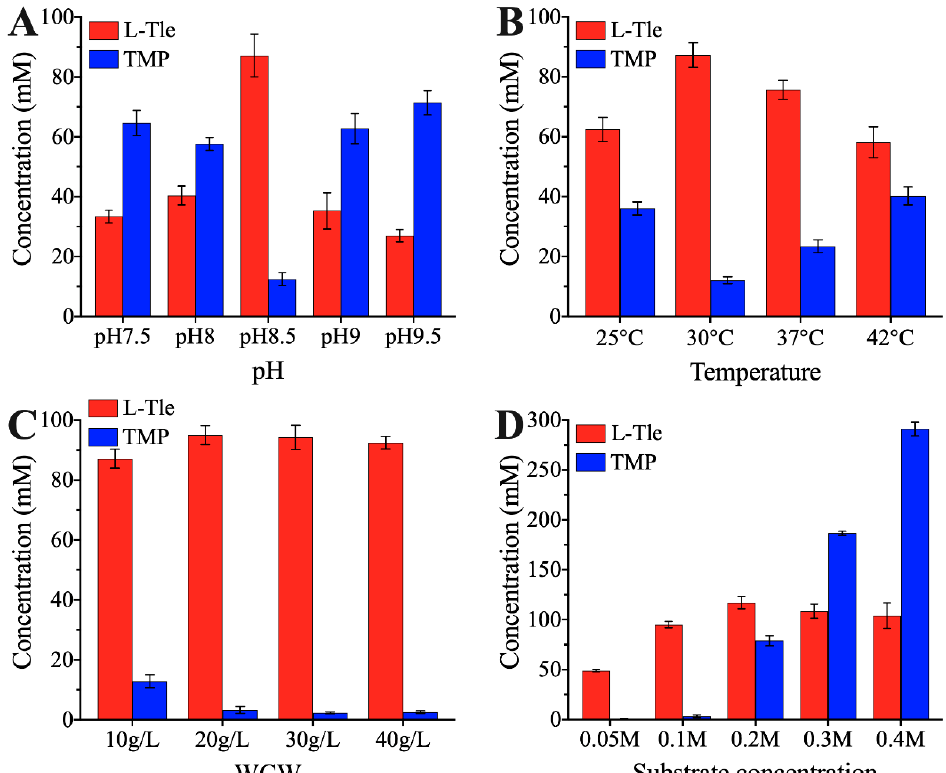
Figure 7. Effects of pH ( A ); temperature ( B ); wet cell weight ( C ), and substrate concentration ( D ) on L-Tle production from TMP by whole-cell biocatalyst of E. coli (pET28a- Pbleudh - Bmgdh ).